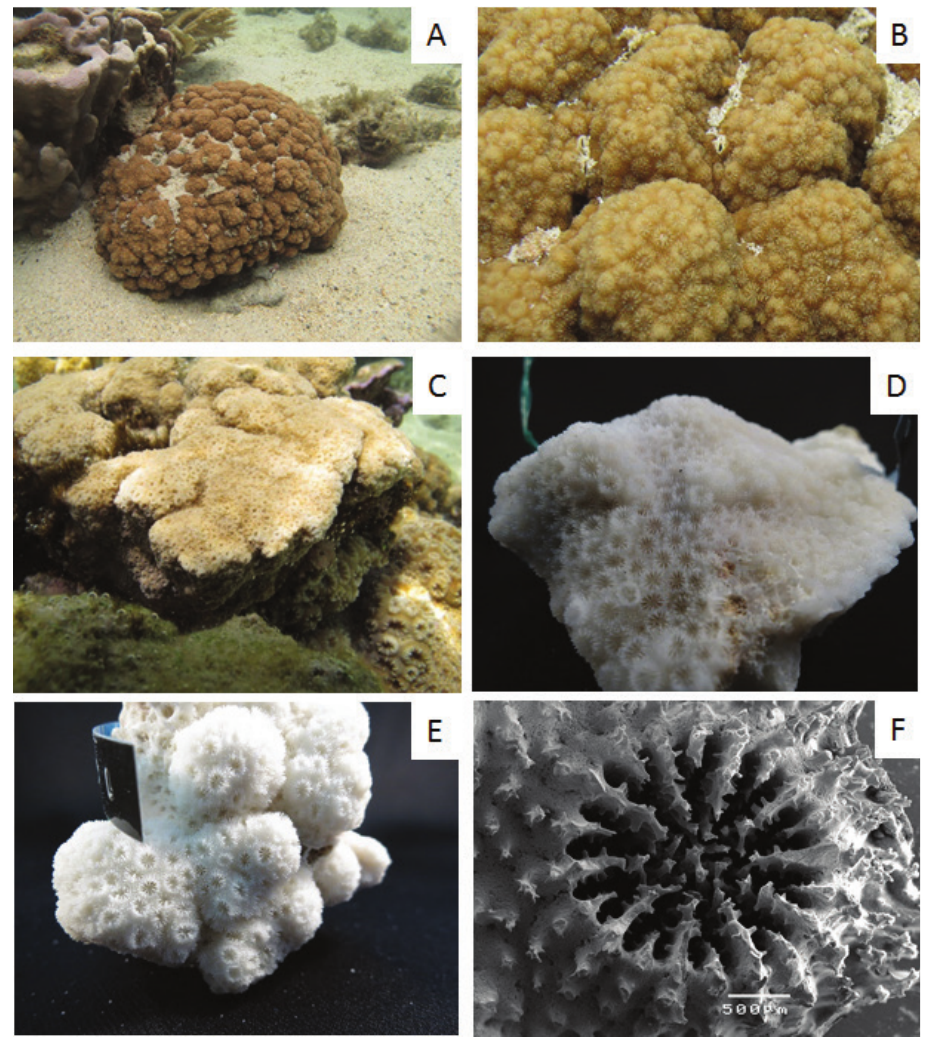
Figure 3. Cyphastrea microphthalma. A, B AM 81-1612 C AM 81_1681 D AM 81-1612 E AM 81-1660 F AM